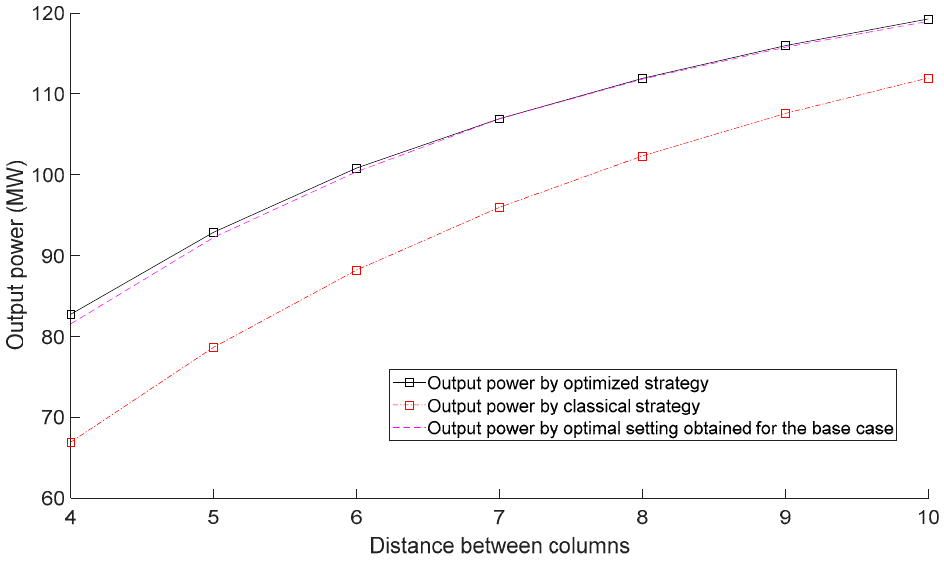
Figure 13. Sensitivity analysis as a function of the distance between columns.